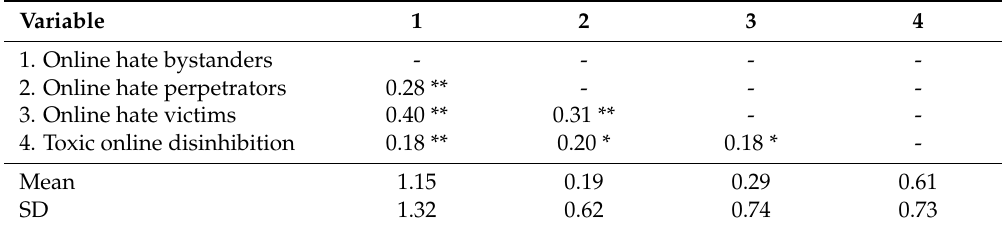
Table 1. Means, standard deviations, and correlations between online hate bystanders, online hate perpetrators, online hate victims, and toxic online